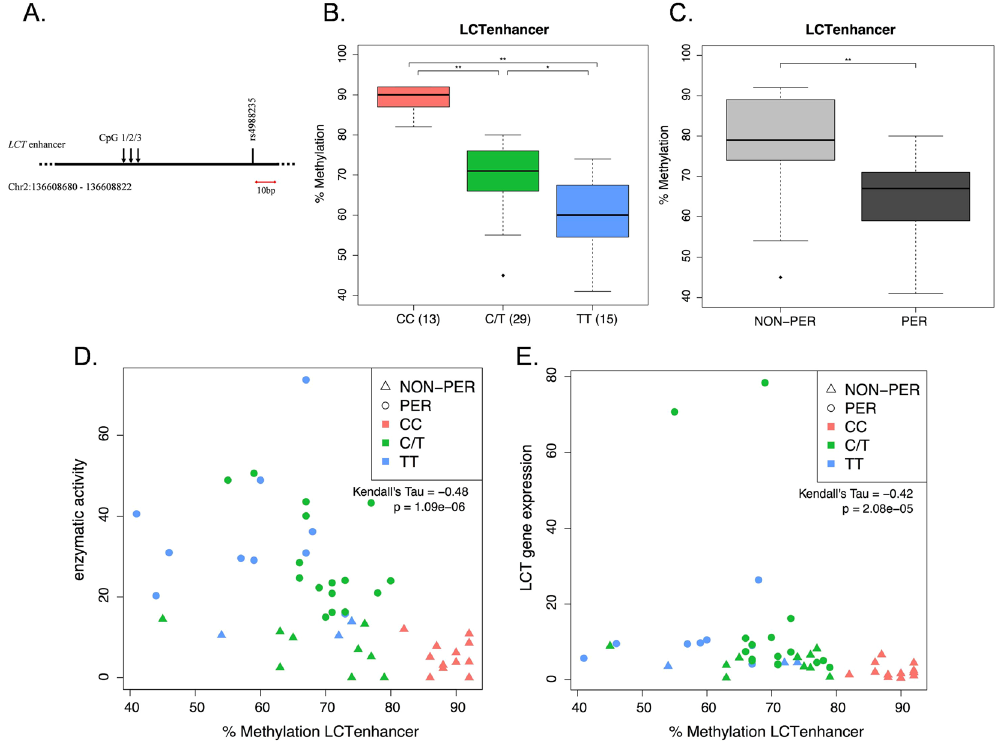
Figure 4. Pyrosequencing of DNA methylation at the LCT enhancer. ( A ) Schematic of LCT enhancer with location of the three CpGs under investigation. The position of − 13910C > T (rs4988235) in relation to the CpGs and the genomic coordinates of the PCR product are also given. ( B) DNA methylation quantification in CC vs. C/T vs. TT individuals, as well as in ( C) Phenotypically Persistent (PER) and Non-persistent (NON- PER) individuals. Student’s T-test was calculated for inter-group comparisons ( * p < 0.05; ** p < 0.001). Number of individuals in each group is given in parenthesis. ( D) Correlation between DNA methylation averaged over the three CpGs and lactase enzymatic activity (enzymatic activity data from Baffour-Awuah et al . 8 ). ( E) Correlation between DNA methylation averaged over the three CpGs and LCT gene expression ( LCT gene expression data from Baffour-Awuah et al . 8 ).